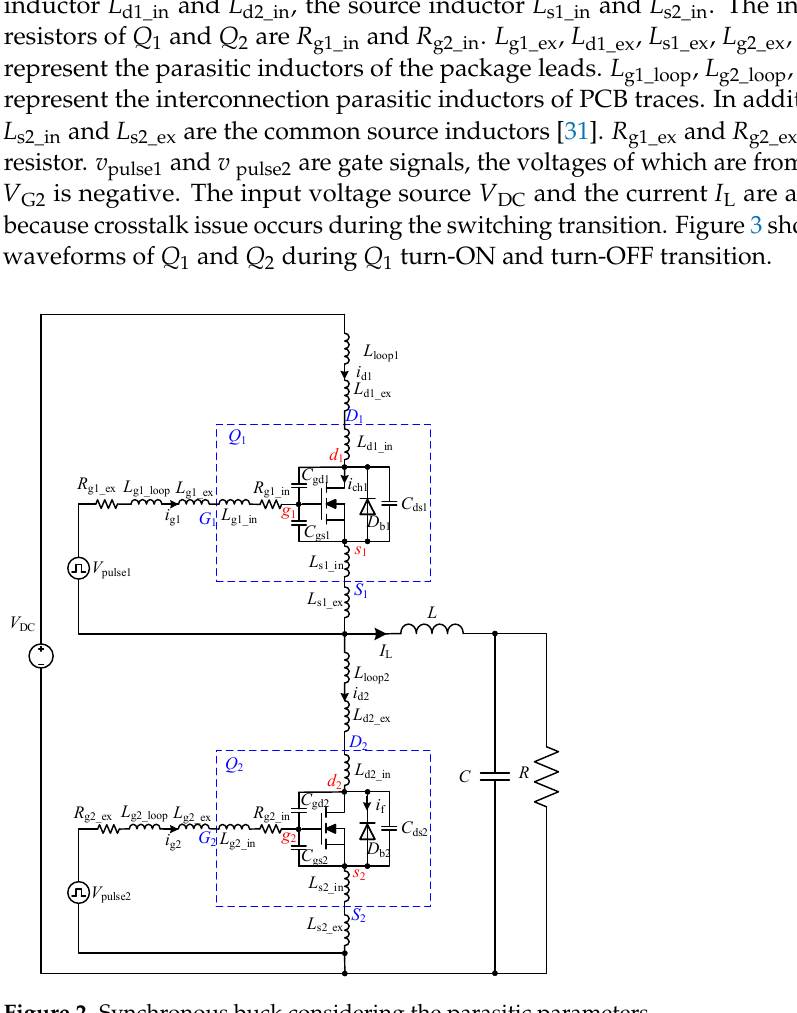
Figure 2. Synchronous buck considering the parasitic parameters.